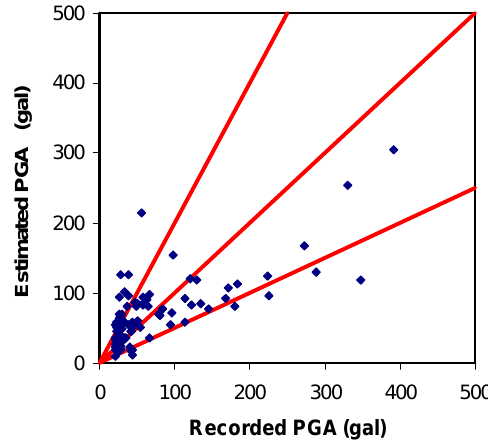
Fig. 10. Distribution diagrams for Kalkan and G¨ulkan (2004). Figure 10. Distribution diagrams for Kalkan and Gülkan (2004) Table 6. Performance of empirical predictive models recently de- veloped for Turkey in case of south-west Turkey